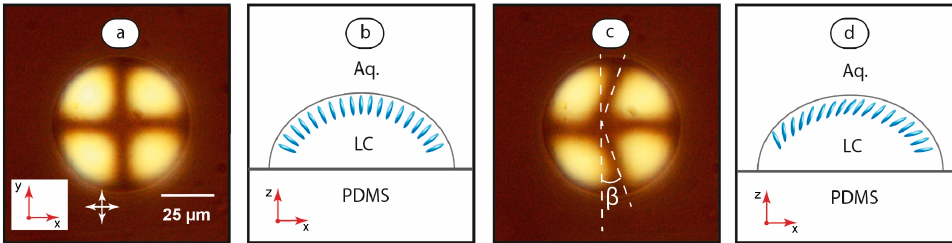
Figure 5. LC droplet immobilized on the microchannel bottom under stationary flow conditions ( a ) with the assumed orientation of the mesophase molecules at the LC-water interface ( b ) and at the flow velocity of 5 mm/s ( c ) with the assumed orientation of the mesophase molecules at the LC-water interface ( d ). Red arrows demonstrate coordinate axes with respect to Figure 1. Crossed white arrows indicate positions of polarizers.